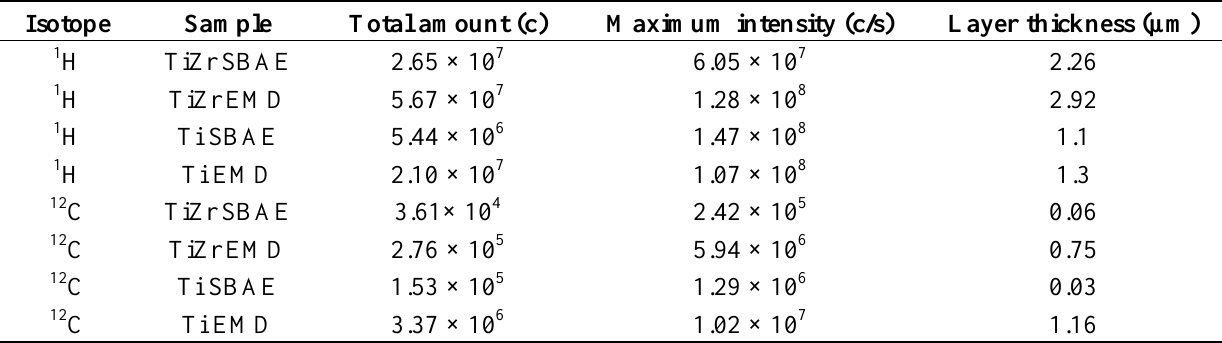
Table 1. SIMS depth profile analysis parameters for the 1 H and 12 C